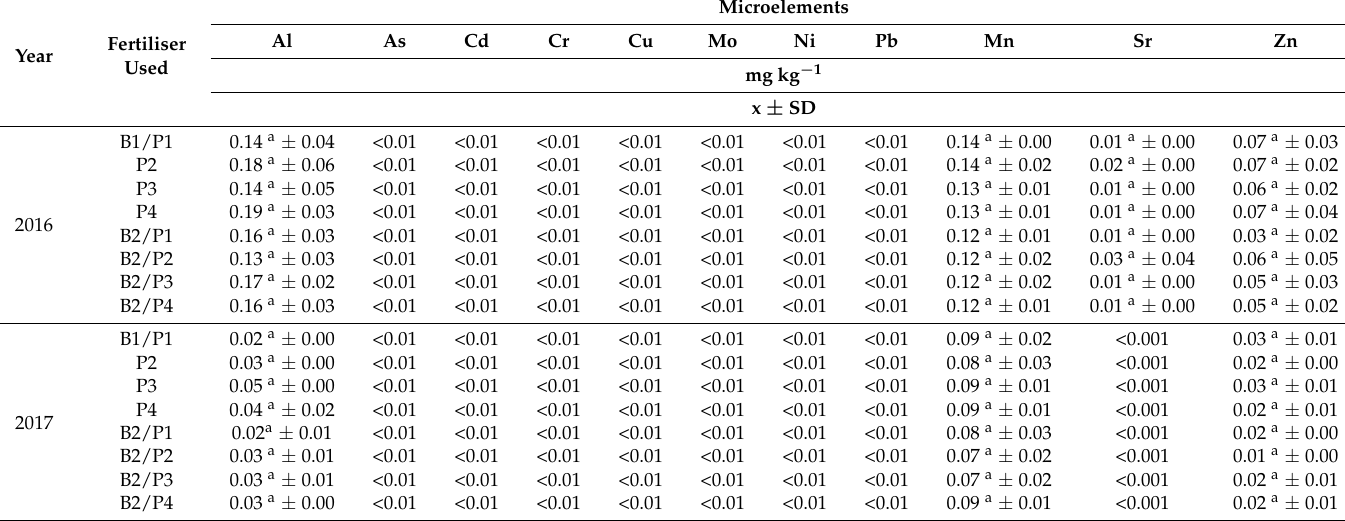
Table 6. Contents of selected microelements and heavy metals in the biomass of giant miscanthus after the first (2016) and second (2017) year of cultivation, depending on the fertiliser